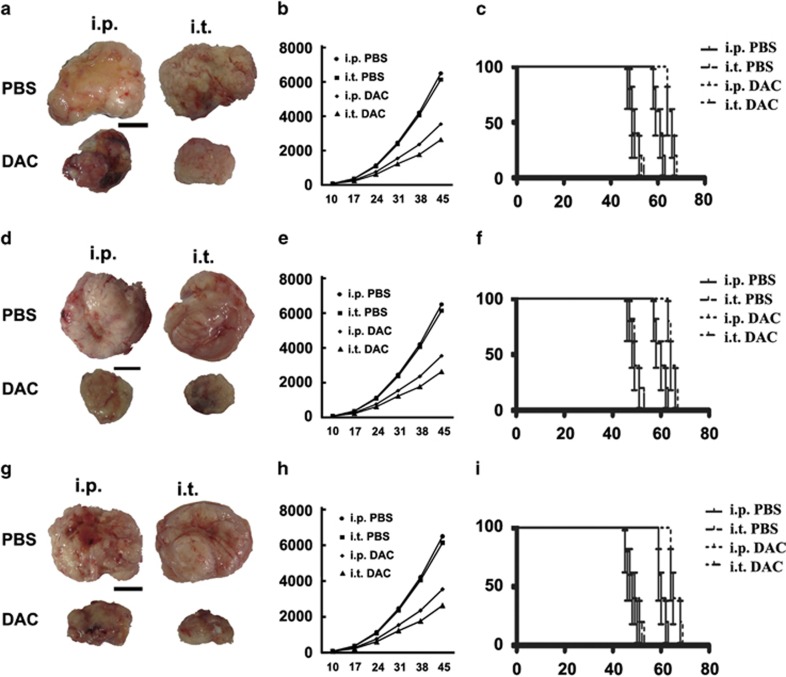
The effect of DAC treatment on colon cancer in vivo. (a, d and g) LS174T, LoVo and Hct116 tumor tissues in the murine model before and after DAC treatment. The tissues in the DAC treatment groups were much smaller than in the control groups, and the i.t. group exhibited the smallest samples. (b, e and h) The mean volume of LS174T, LoVo and Hct116 cancer tissues in the murine model before and after DAC treatment. DAC treatment by i.t. resulted in the smallest volumes. (c, f and i) The survival analysis of the LS174T, LoVo and Hct116 murine model. The drug-treated groups lived significantly longer than the drug-free groups, and the group in which DAC was i.t. injected lived longer than the group receiving i.p. injection